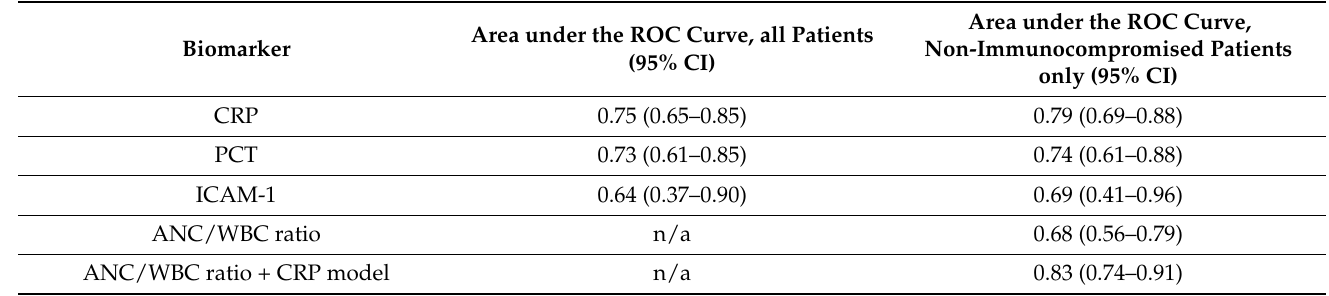
Table 6. The area under the ROC curve for selected biomarkers for the diagnosis of SBI. Area under the ROC Area under the ROC Curve, all Patients Biomarker (95% CI)